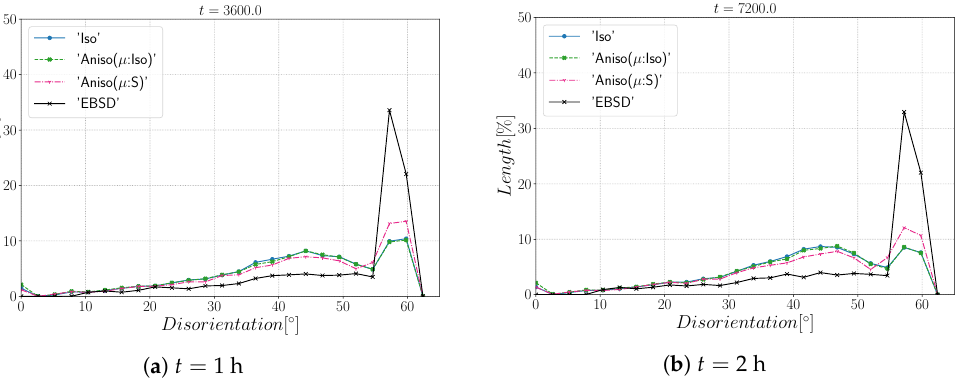
Figure 28. Disorientation distribution obtained at ( a ) t = 1 h and ( b ) t = 2 h for the isotropic (Iso) formulation, anisotropic formulations with isotropic GB mobility (Aniso( µ :Iso)) and heterogeneous GB mobility (Aniso( µ :S)), and the experimental data (EBSD). The Y-axis represents the GB length percentage. Numerical results obtained from the initial immersed microstructure shown in Figure 25a and the GB5DOF code to define the GB energy.